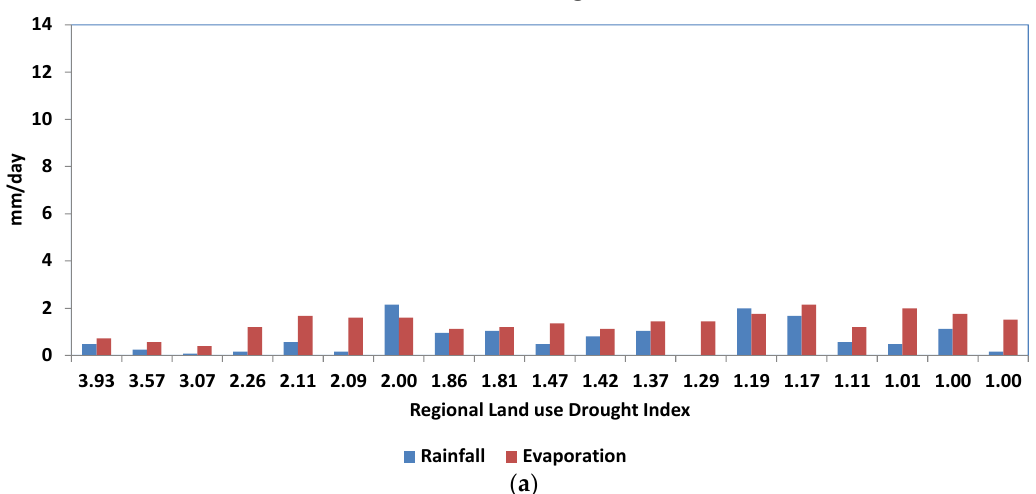
Figure 13. Cont. Figure 13. Cont.